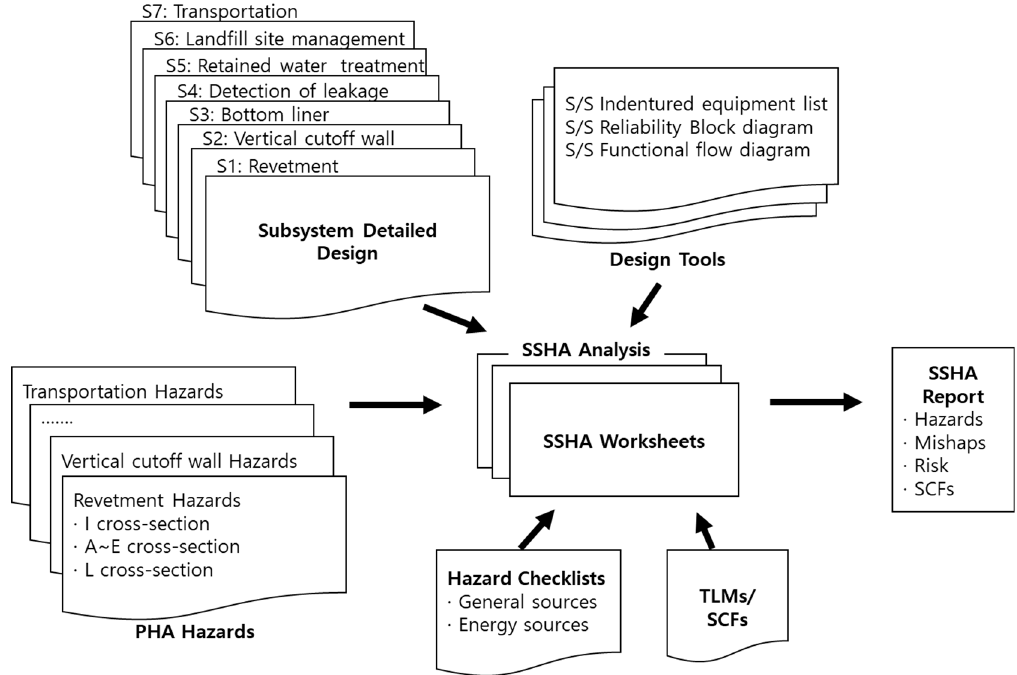
Figure 2. Conceptual diagram of the subsystem hazard analysis for the offshore waste disposal facility. PHA denotes preliminary hazard analysis, SSHA — subsystem hazard analysis, TLM — top- level mishaps, and SCFs — safety critical functions, respectively.